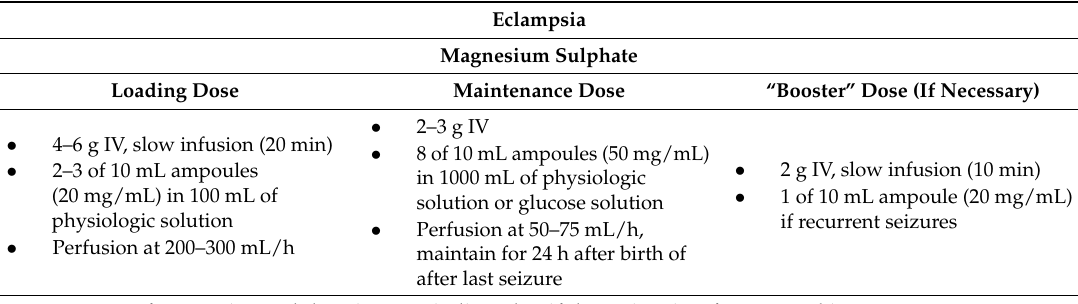
Table 5. Proposed pharmacotherapy for eclampsia